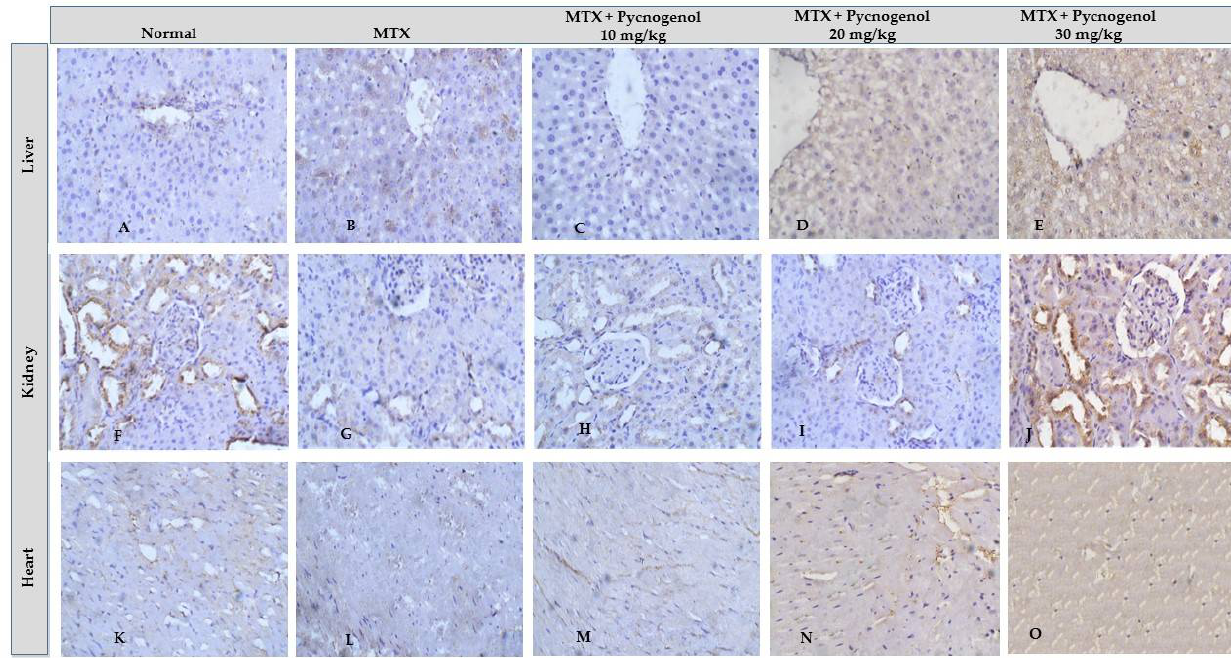
Figure 10. Immunohistochemical staining with IHC-P53 of heart ( A – E ), liver ( F – J ), and kidney ( K – O ) tissue. Differences assessed by Kruskal–Wallis test at p = 0.05.